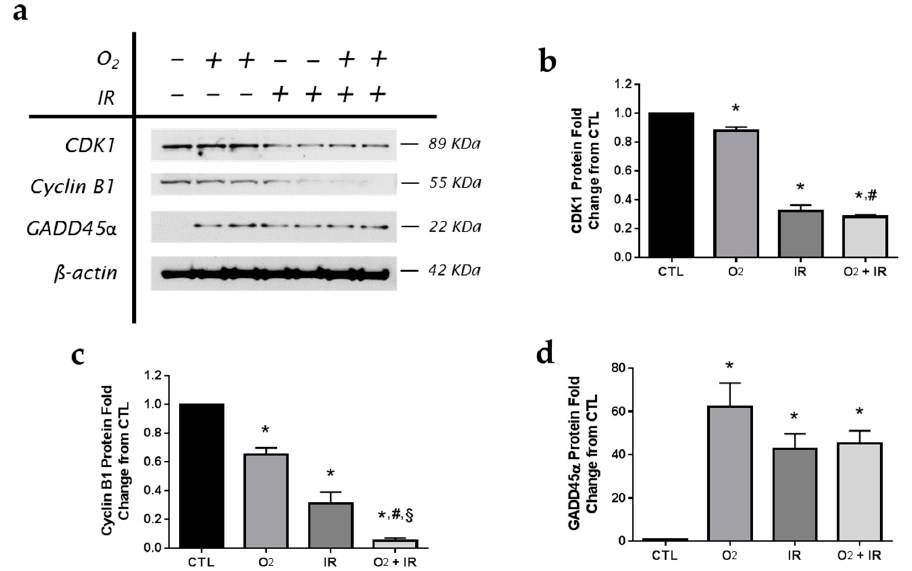
Figure 11. Determination of apoptotic and cell cycle proteins in murine lung tissue following exposure to repeated cycles of O 2 , IR or O 2 + IR exposure. Murine lung tissues ( n = 3/group) were evaluated after 3 cycles of hyperoxia and radiation exposure and evaluated by ( a ) western blotting for CDK1, Cyclin B1, and GADD45 α . Densitometric analysis of band intensity for ( b ) CDK1; ( c ) Cyclin B1; and ( d ) GADD45 α was normalized to β -actin and values are expressed as fold change from CTL. Data are presented as mean ± SEM. * p < 0.05 for each exposure condition as it compares with the unexposed control (CTL) in the same respective time-group; # p < 0.05 for significant differences between O 2 -alone compared to O 2 + IR; § p < 0.05 for significant differences between IR-alone compared to O 2 + IR.